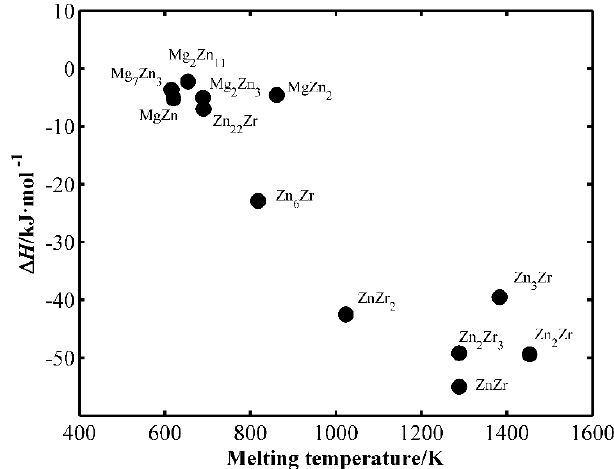
Figure 4. Relationship between enthalpies of formation and melting temperature [32] of some binary inter-metallics.